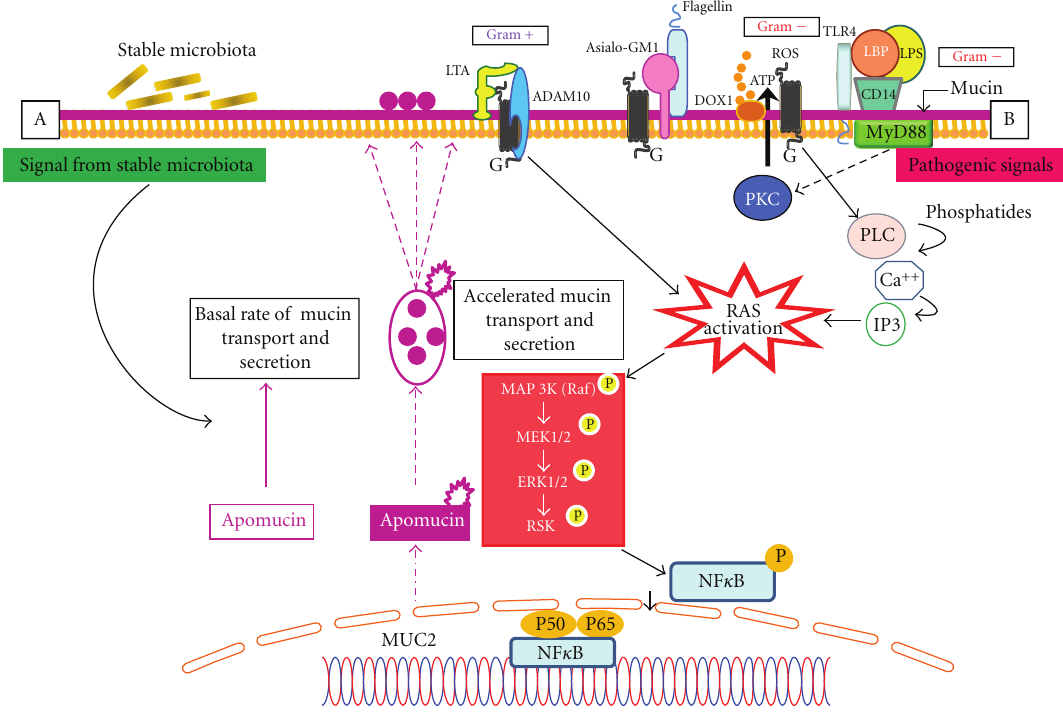
Figure 3: Under normal physiological conditions, mucin secretion occurring at a stable rate (A) with signals from stable (commensal) microbiota. Mucin secretion is accelerated (B) upon activation by pathogenic organisms. In gram negative bacteria (e.g., Pseudomonas aeruginosa ), both LPS (lipopolyscaccharide) and flagellin signal activation of RAS-MEK1/2-ERK1/2 (reticulo-activating system-pathway— meiosis-specific serine/threonine protein kinase-extracellular signal-regulated kinase) pathways. Bound to LPS binding protein (LBP), LPS uses a toll-like receptor (TLR). Flagellin binds to a glycolipid receptor, Asialo-GM1, which is calcium dependent. Lipoteichoic acid (LTA), a component of gram positive bacteria, binds to platelet activating factor (PAF) and activates ADAM10 (adhesion and protease domain molecule) which engages RAS/RAF/MEK/ERK/pp90RSK/NF κ B and MUC2 (intestinal mucin)